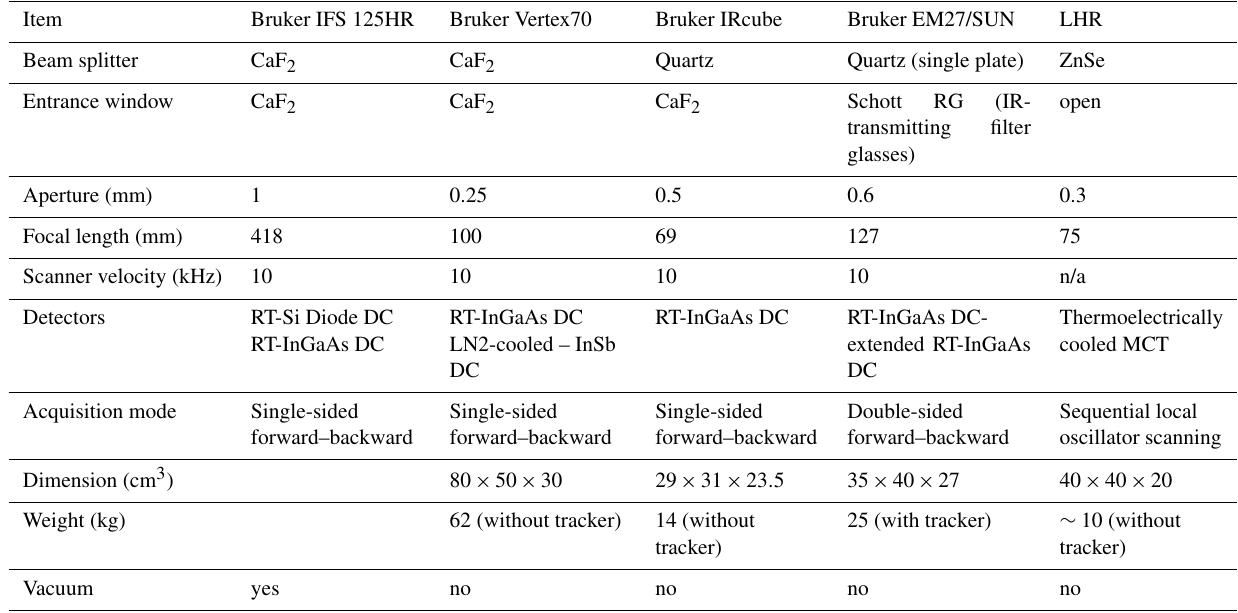
Table 1. List of instruments participating in the FRM4GHG campaign in 2017 and their properties; n/a indicates not applicable.